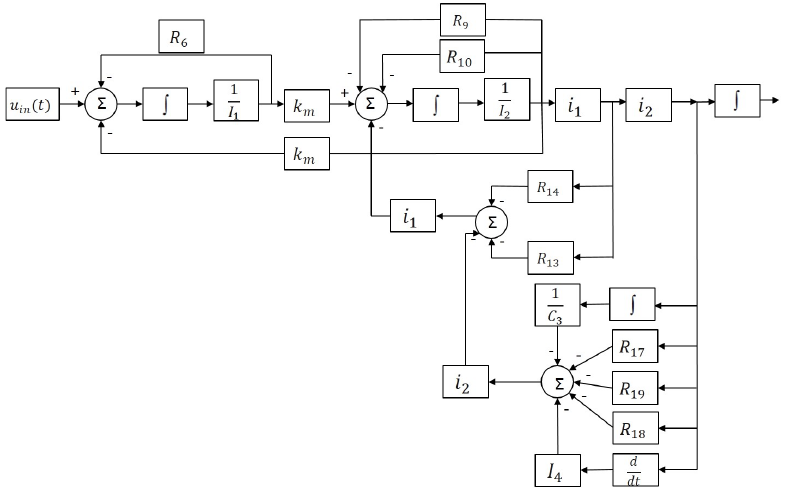
Figure 7. Block diagram of the ACV actuator